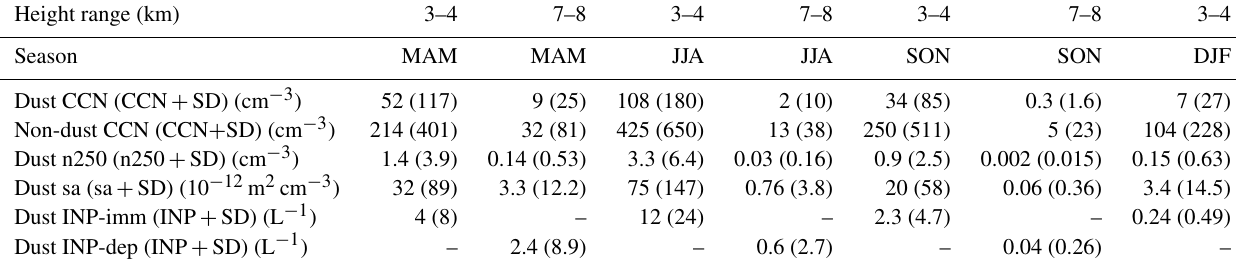
Table 4. Overview of layer mean values of INP-relevant aerosol properties (n250 for large particle concentration, sa for surface area con- centration) and CCN and INP concentrations for the 3–4 and 7–8km layers for spring (MAM), summer (JJA), autumn (SON), and winter (DJF). Immersion-freezing INP concentrations (INP-imm) are given for − 25 ◦ C and deposition-nucleation INP concentrations (INP-dep) for − 50 ◦ C and an ice supersaturation value of 1.15. The range of values is indicated by the sum of the mean values + SD (in parentheses). Height range (km)